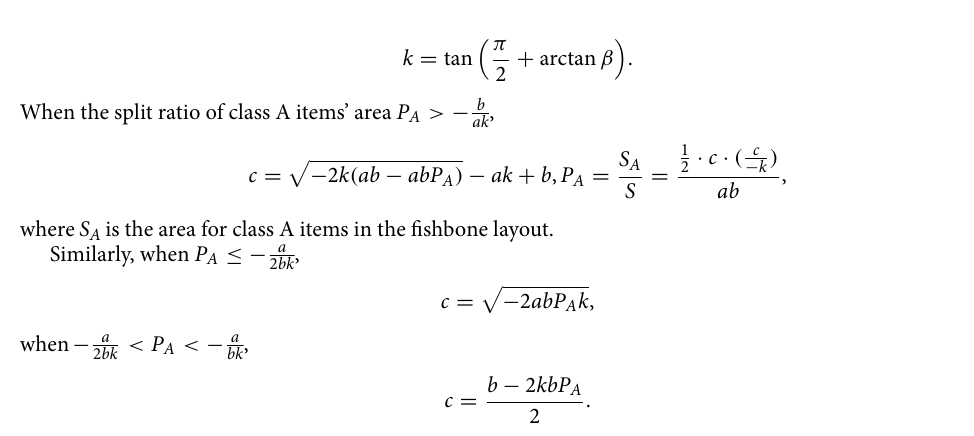
Figure 4. Fishbone layout under the class-based storage